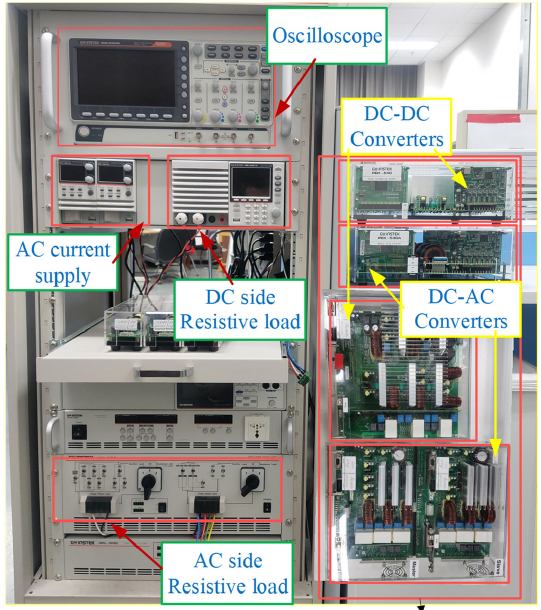
Figure 17. The prototype of an AC microgrid. Table 3. Parameters of the AC microgrid prototype.